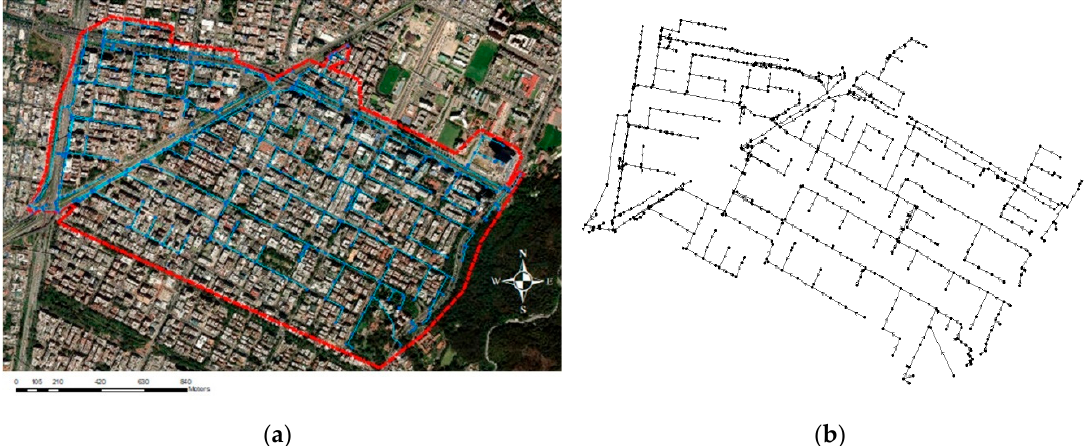
Figure 5. ( a ) Location of Southern Chicó Network. ( b ) Storm Water Management Model (SWMM) for Southern Chicó Network.3.2. Northern Chicó Network.